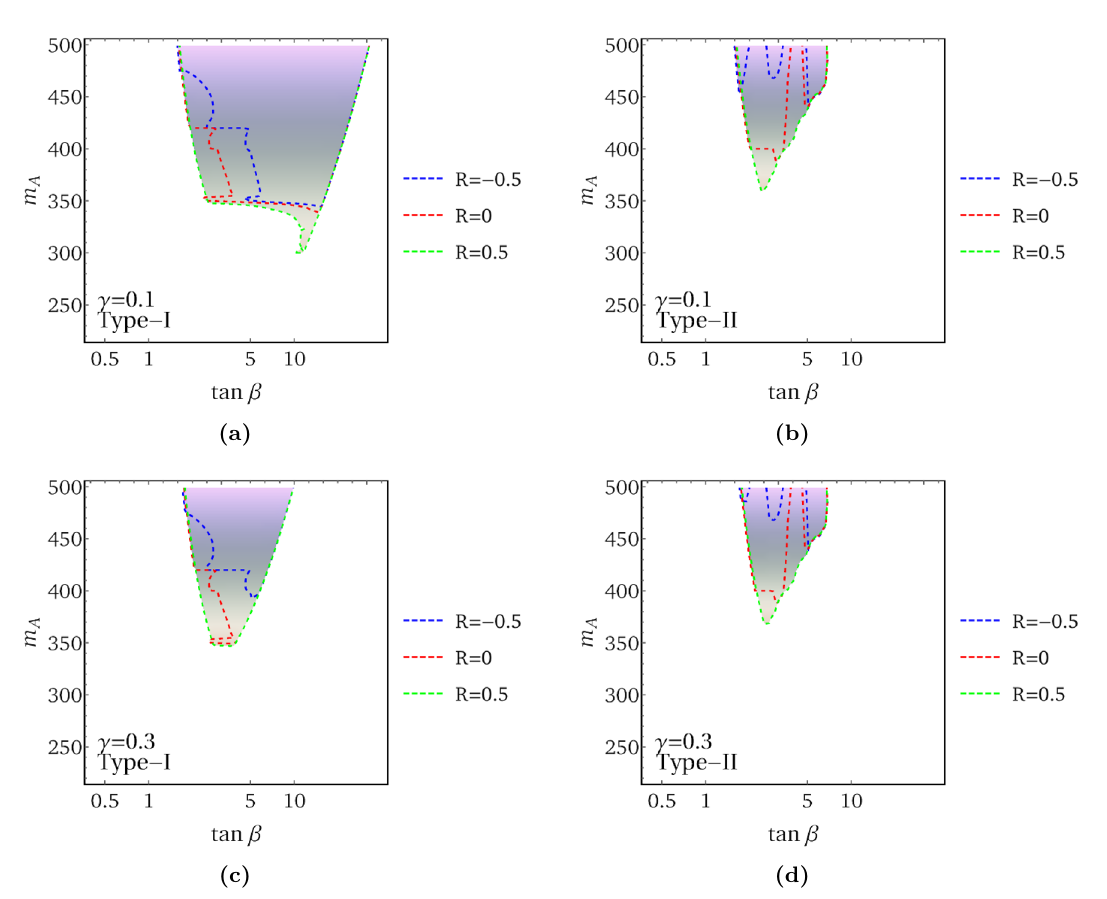
Figure 8. Projected regions allowed by experimental bounds anticipated at the high-luminosity LHC with 3000 fb − 1 of data, assuming m T = 2 . 5 TeV with an m 2 and ∆ m 2 tuning of at most 12 5% . Each panel shows three different R contours; the white regions of the parameter space are ruled out. The ruled out areas expand somewhat as R decreases, with the borders of the allowed shaded regions indicated by the corresponding contours. Panels (a) and (c) correspond to Type-I Yukawa couplings, and panels (b) and (d) correspond to Type-II Yukawa couplings. Panels (a) and (b) employ the γ = 0 . 1 benchmark, whereas panels (c) and (d) employ γ = 0 . 3